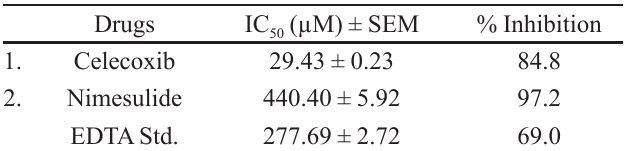
TABLE I - Effects of COX inhibitors on phosphodiesterase 1